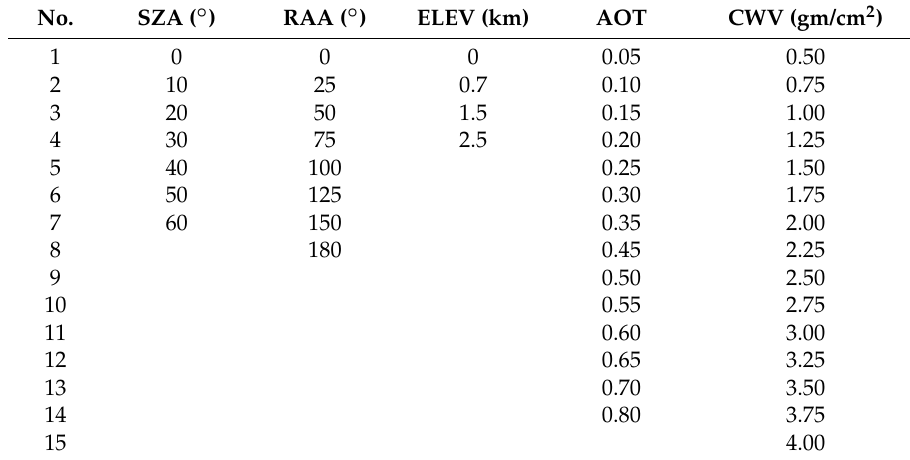
Table 2. the breakpoint location of the